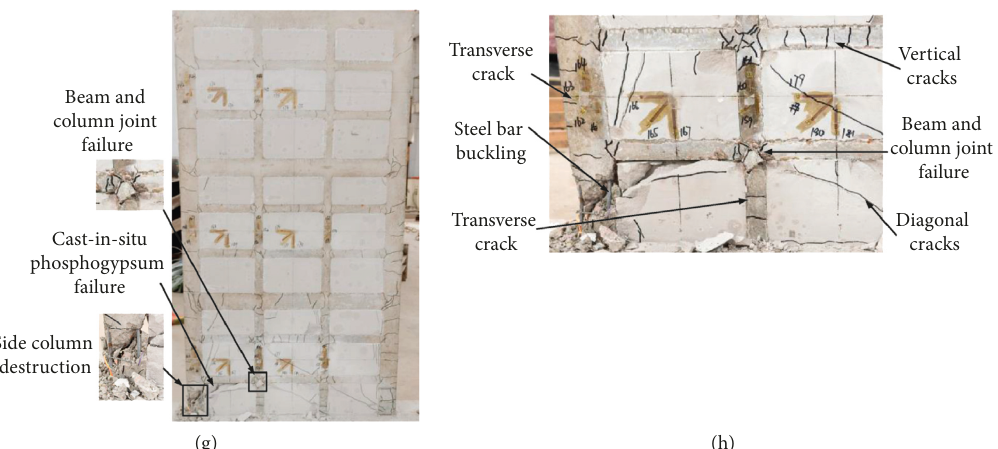
Figure 12: Failure modes of each specimen. (a) Specimen KJ1. (b) Specimen KJ2. (c) Specimen KJ3. (d) Specimen ZHQ1. (e) Specimen ZHQ2. (f) Specimen ZHQ3. (g) Specimen ZHQ4. (h) Details of the